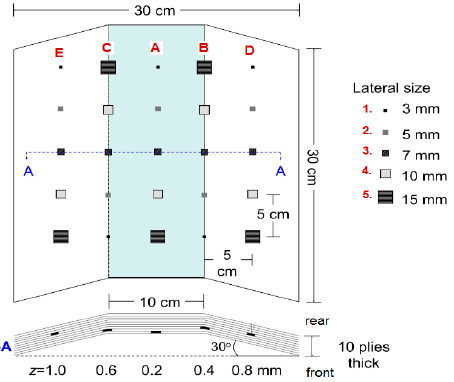
Figure 1. Schematic representation of defects characteristics and sample description.